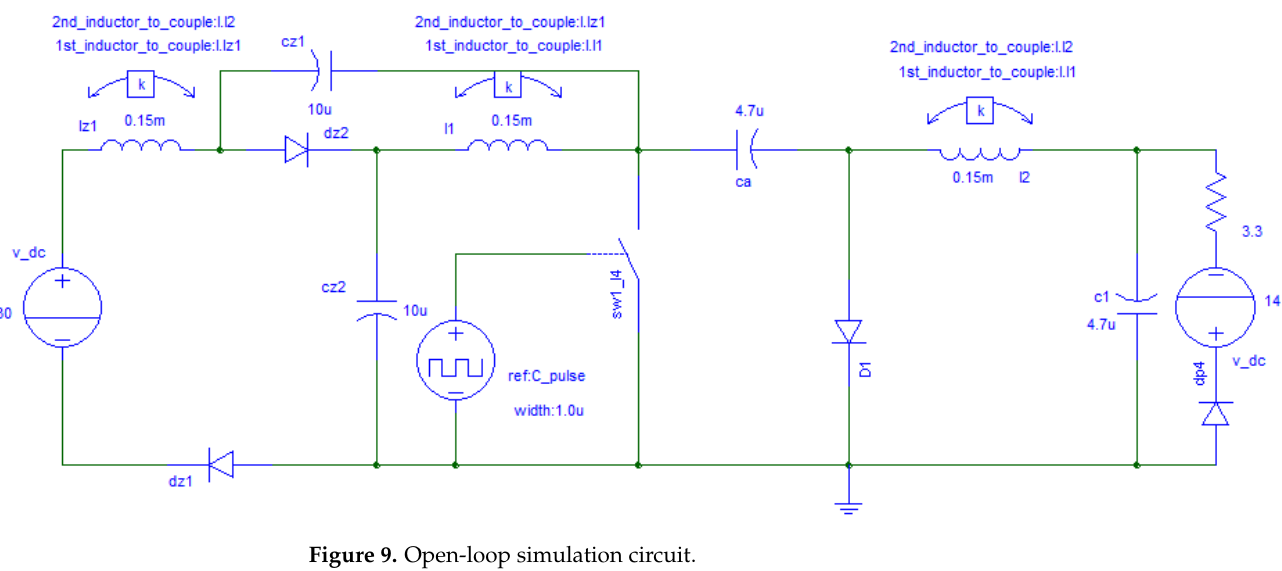
Figure 9. Open-loop simulation circuit.